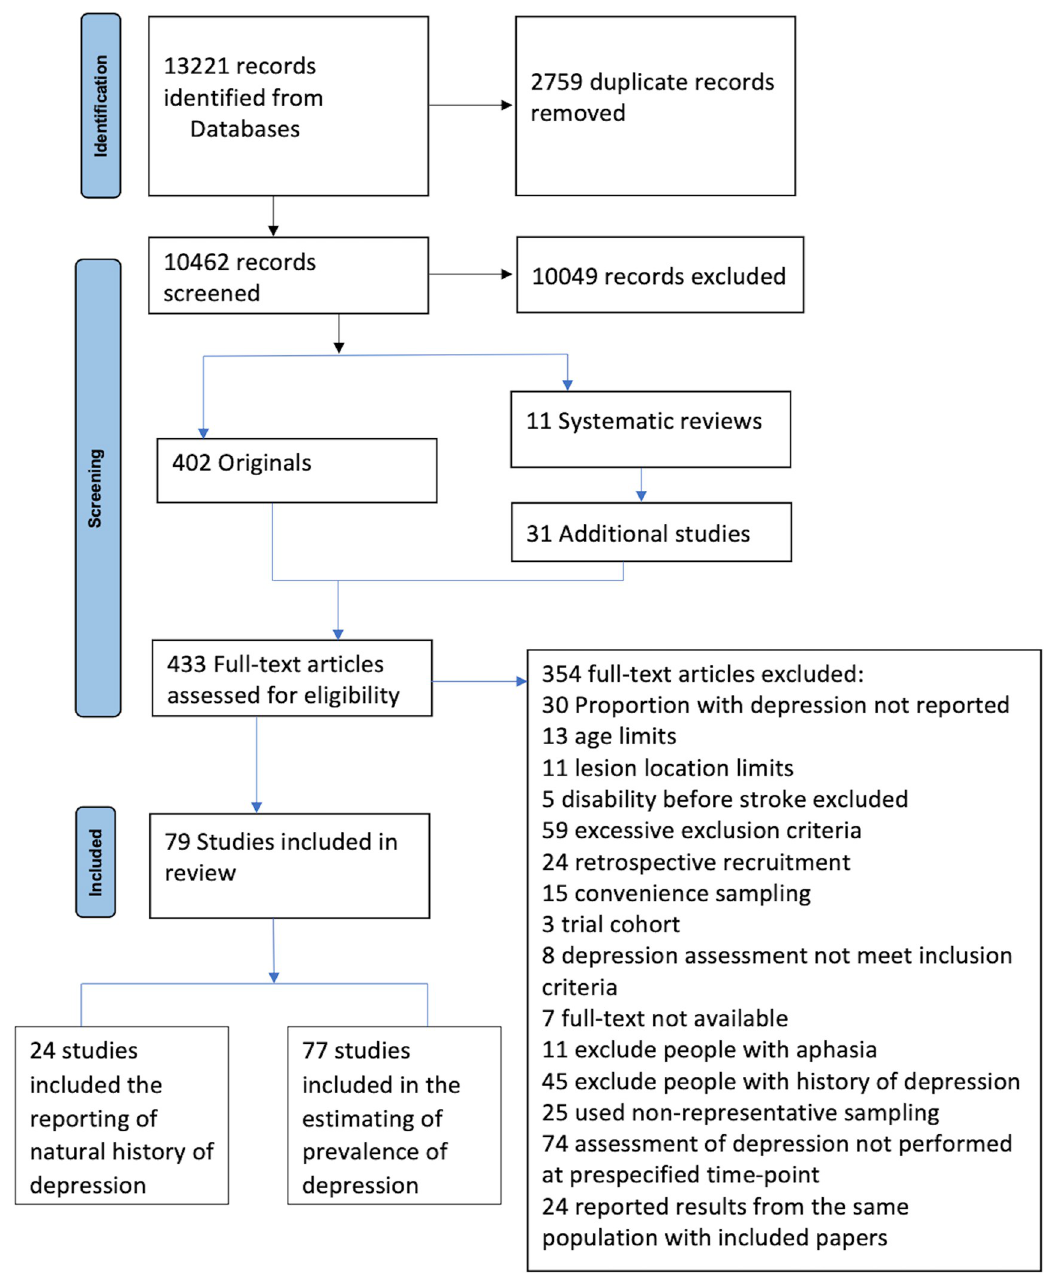
Fig 1. PRISMA flow diagram of literature